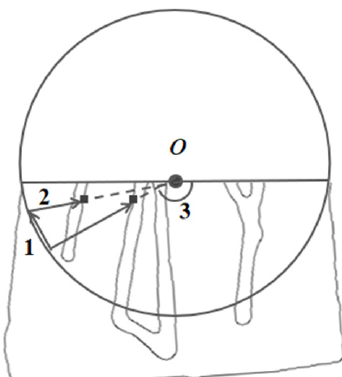
Figure 10. The establishment of the underwater image model of obstacles.